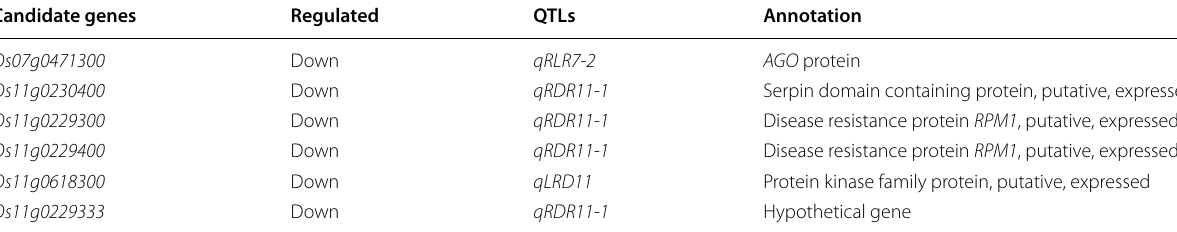
Table 1 Candidate genes expressed differentially under low nitrogen conditions Candidate